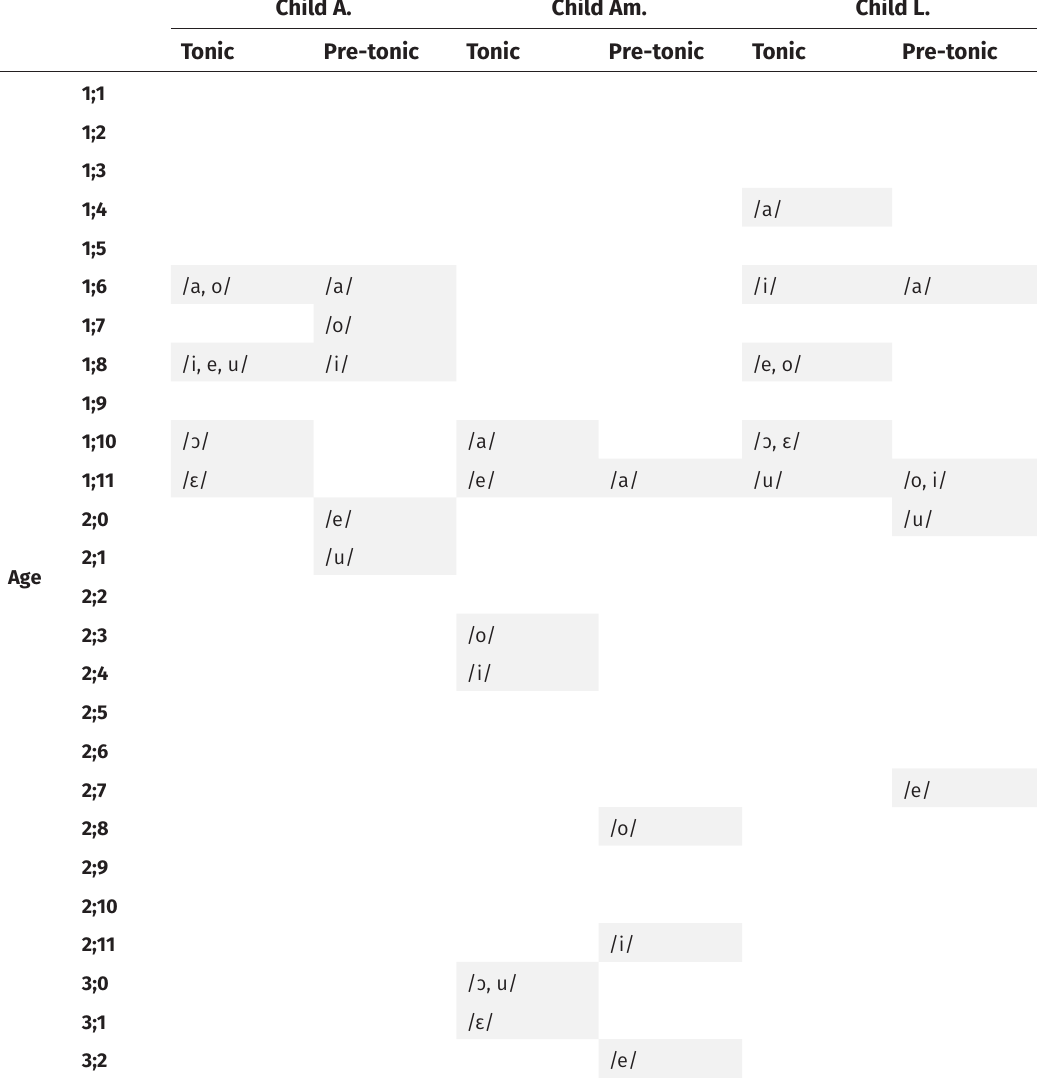
Table 1: The acquisition of tonic and pre-tonic vowels (Bohn